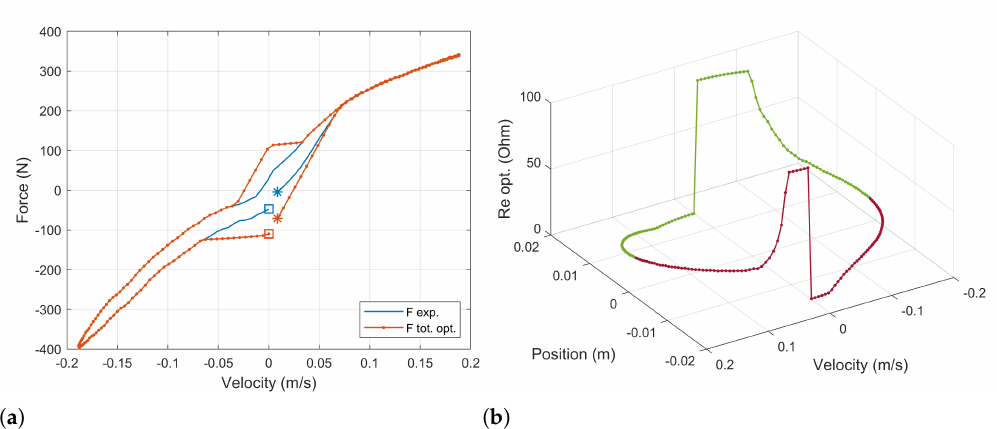
Figure 6. ( a ) Final comparison of the force–velocity diagrams for the optimized ball-screw damper the baseline damper. ( b ) Optimal values of the external load resistor ( R e ) obtained to emulate the baseline damper’s response for the sinusoidal input